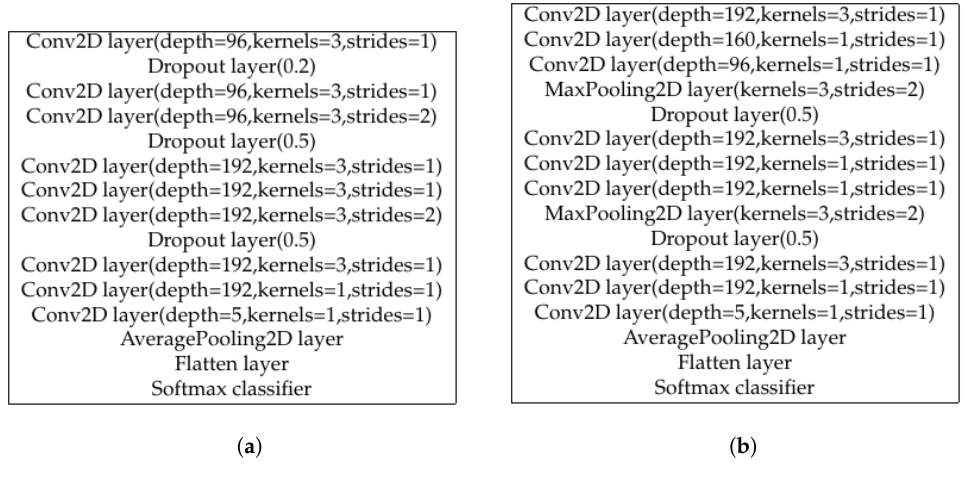
Figure 2. The brief structures of an AllConv model and a NiN model for CV-QKD attack detec- tion. ( a ) The structure of our AllConv network. ( b ) The structure of our NiN network. More detailed introduction can be seen in Appendix B. AllConv: all convolution network. NiN: Network in